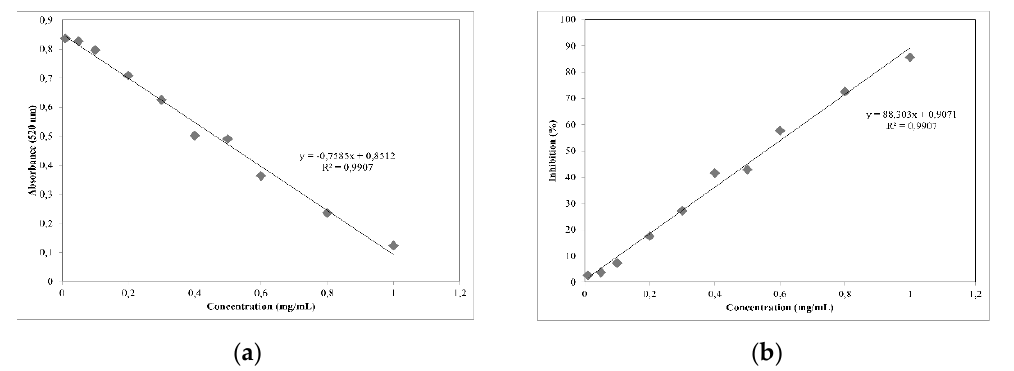
Figure 1. DPPH ● scavenging activity analysis ( a ) Absorbance values of different concentration of extract ( b ) Inhibition values of di ff erent concentration of PBM in DPPH ● scavenging assay.